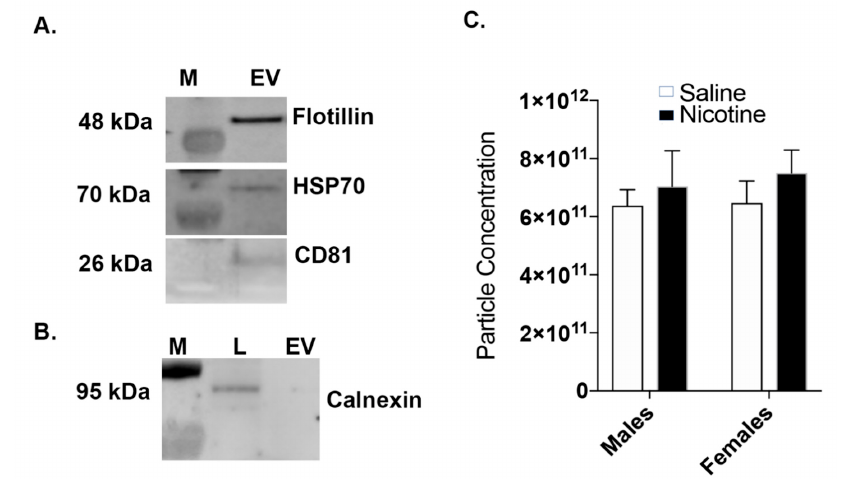
Figure 2. Validation of BDEV purity. ( A ) Western blot analysis on BDEV isolated from a control saline animal shows the expression of the positive markers CD81, flotillin-1, and Hsp70. ( B ) The negative marker calnexin was enriched in the whole tissue lysate (L) but absent in the EVs fraction (EV). ( C ) Nano tracking analysis (NTA) shows an increase in BDEV particle concentration in both and male and female rats exposed to nicotine. However, no significant changes in concentrations of isolated BDEVs from the two treatment groups between the sexes was observed as determined by a 2-way ANOVA followed by Sidak’s multiple comparison test.